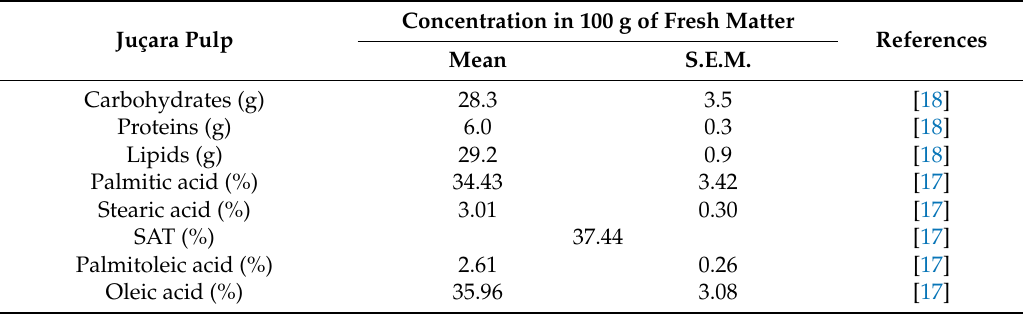
Table 1. Juçara composition adapted from Santamarina et al.